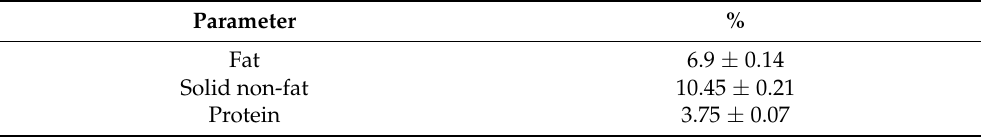
Table 1. Chemical composition of raw buffalo milk